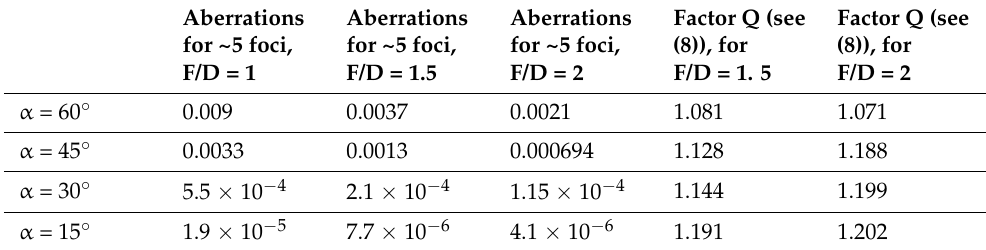
Table 6. Aberrations and Q factors for lenses with M = 1; D = 10 λ